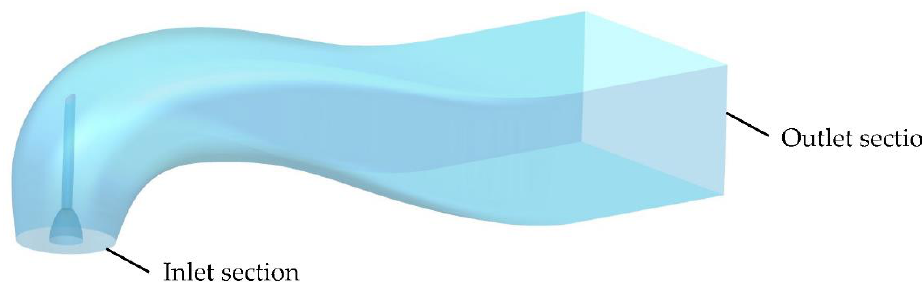
Figure 2. Three-dimensional model diagram of low hump outlet conduit.